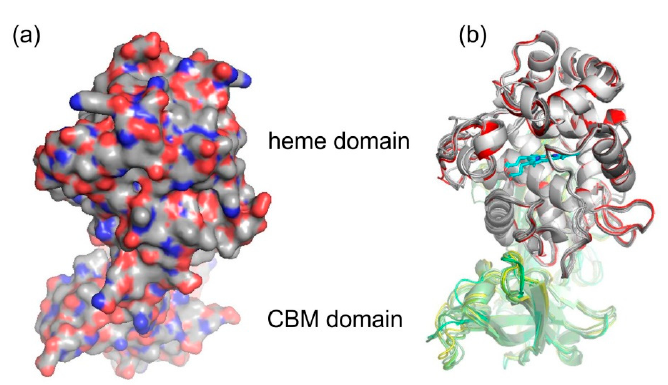
Figure 5. Structural presentation of a 3D model of S. cepivorum Hybrid B heme peroxidase in overlay with its direct ancestor (nodes A–F shown in Figure 3) reconstructed with AlphaFold 2 [25]. ( a ) surface presentation of the whole protein with usual colour scheme for amino acids; ( b ) domain organisation, colour scheme: red—peroxidase domain of ScepHyBpox1, grey—peroxidase domains of ancestors A-F, yellow—CBM domain of ScepHyBpox1, green—CBM domains of six ancestors, cyan—prosthetic heme